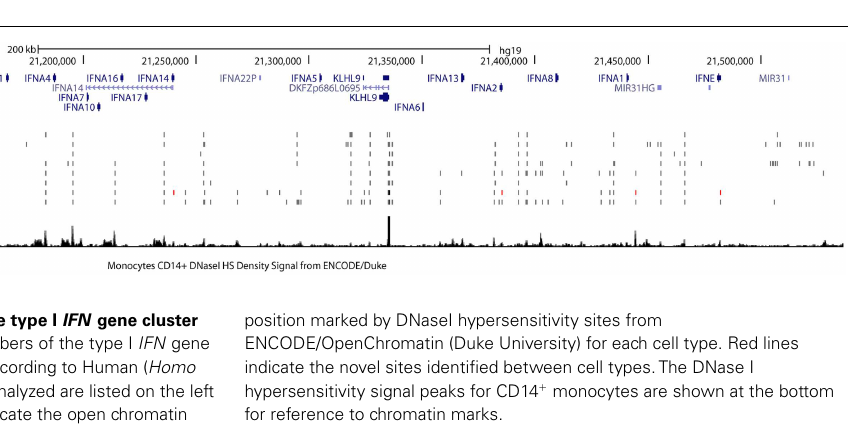
FIGURE 1 | H3K4me3 peaks and methylation tracks on the type I IFN gene cluster . Members of the type I IFN gene cluster are shown and illustrated proportionally according to Human ( Homo sapiens ) Genome hg19. H3K4me3 peaks and UCSC DNA methylation tracks are shown for a human B cell line.